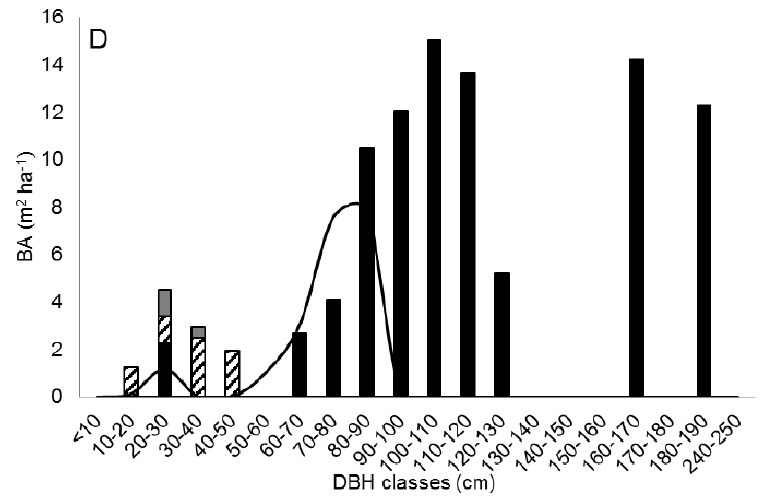
Figure 3. DBH distributions by species of groups S, Is, Id, and D classified by cluster analysis (Figure 2). Data are means of stands belonging to the same groups. Snags and Logs = line graphs; Species = bar graphs. PSME: Pseudotsuga menziesii (Mirb.) Franco, TSHE: Tsuga heterophylla (Raf.) Sarg., THPL: Thuja plicata Donn ex D. Don, and ABAM: Abies amabilis (Dougl) Forbes. Others: Abies grandis (Douglas ex D. Don)